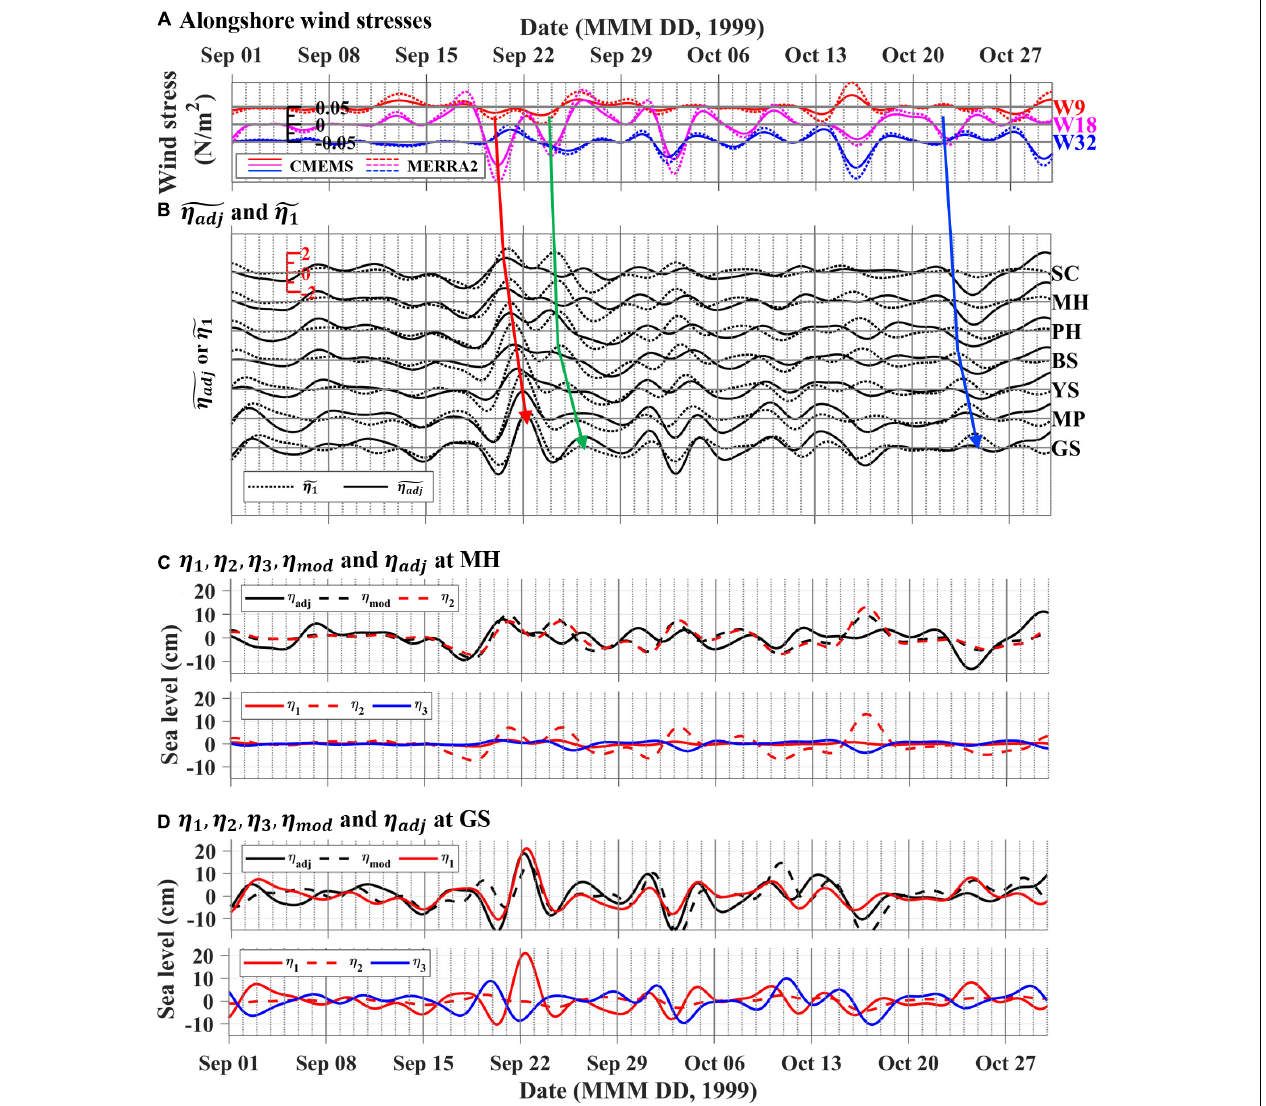
FIGURE 7 | Time-series of (A) τ y (colored solid lines for CMEMS blended satellite wind and colored dashed lines for the MERRA2 reanalysis wind) at three wind grids (W9, W18, and W32) located north of SC (colored squares in Figure 1 ), (B) g η adj (solid line) and e η 1 (dotted line) at the 7 TG stations 1 September to 30 October 1999. In (A,B) , the propagations of η adj and η 1 , as well as the related τ y described in section “Comparison Between Observed and Modeled Sea Level Propagations,” are highlighted by colored arrows. The time-series of η adj and η mod ( = η 1 + η 2 + η 3 ) are shown at (C) MH and (D) GS. In the upper panel of (C,D) , the η adj and η mod are represented by black solid and black-dashed lines, respectively. The η 2 (red-dashed line) and η 1 (red solid line), which are the most dominant at each station, were overlapped in the upper panels of (C,D), respectively. In the lower panels of (C,D) , the red solid, red-dashed, and blue solid lines denote η 1 , η 2 , and η 3 ,